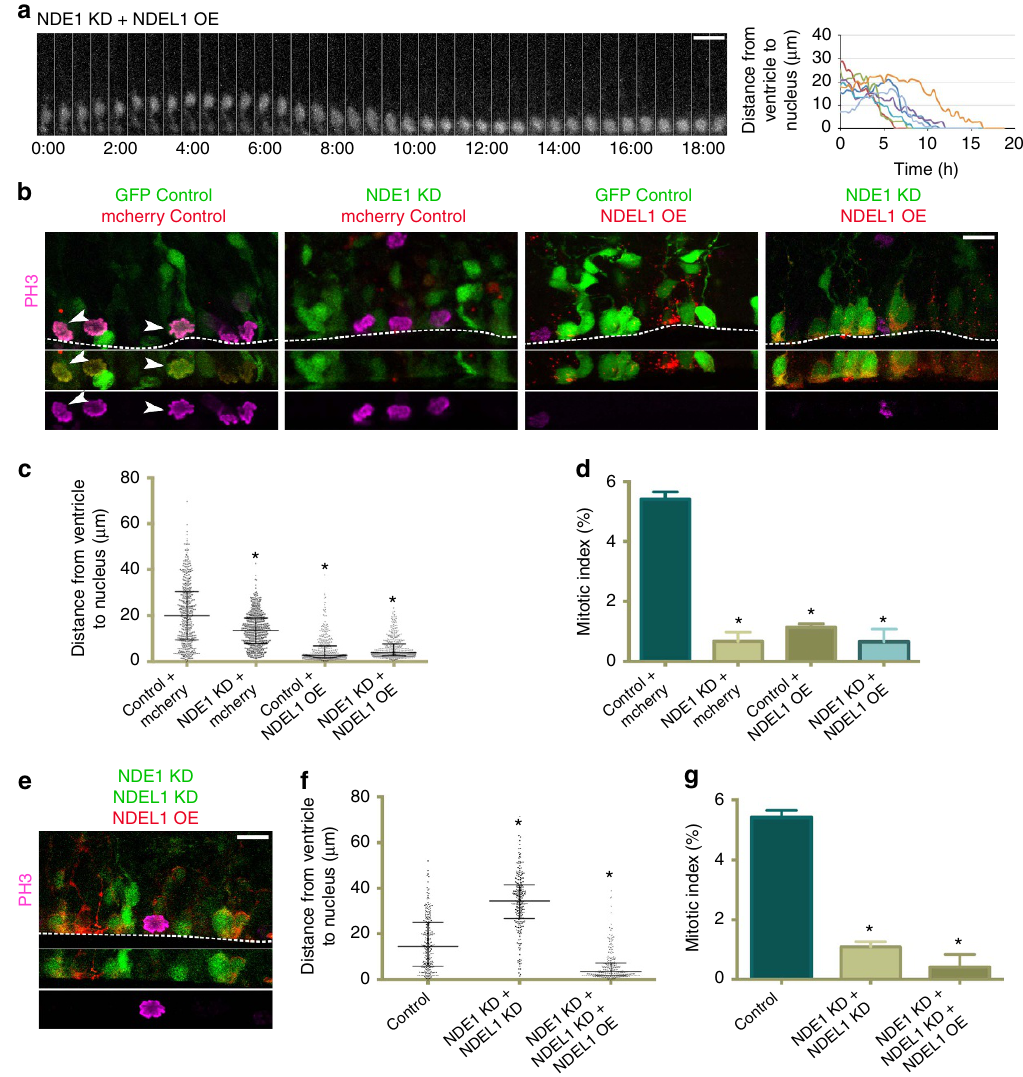
Figure 7 | NDEL1 overexpression rescues apical nuclear migration but not mitotic entry in NDE1 deficient radial glia progenitors. cDNA for NDEL1 was co-electroporated into embryonic rat brains with a GFP control empty vector or along with NDE1 shRNA or NDE1 and NDEL1 shRNAs at E16, and analysed at E20. ( a ) NDEL1 overexpression rescues apical interkinetic nuclear migration (INM) in radial glia progenitors (RGPs) where NDE1 has been knocked down, but these cells accumulate at the ventricular surface after apical INM, where they remain for hours without any evidence of mitosis. Montage panels are shown at 30min intervals. Full movie can be found in Supplementary Movie 7). ( b ) Representative images of NDEL1 overexpression on both a wild-type and NDE1 RNAi background reveals an accumulation of the majority of RGP nuclei at the ventricular surface in a PH3 negative state. Arrowheads mark electroporated cells in mitosis. Dashed line represents the ventricular surface. ( c ) NDEL1 overexpression causes nearly all RGP soma to accumulate at the ventricular surface regardless of whether NDEL1 is overexpressed on a wild-type or NDE1 RNAi background. ( d ) Even though NDEL1 overexpression caused an accumulation of RGP soma at the ventricular surface, the mitotic index remained reduced to a level similar to NDE1 knockdown alone. ( e ) Representative image of RNAi-resistant NDEL1 overexpression with NDE1/NDEL1 double knockdown in RGP cells stained for PH3. Dashed line represents the ventricular surface. ( f , g ) RNAi-resistant NDEL1 overexpression with NDE1/NDEL1 double knockdown caused an accumulation of RGP soma at the ventricular surface similar to overexpression of NDEL1 on a wild-type or NDE1-deficient background, and once again failed to rescue the mitotic index. Data are presented as scatterplot in c and f with bars representing the median ± the interquartile range, and as mean ± s.e.m. in d and g . Kolmogorov–Smirnov test for non- parametric distributions used in c and f (* P o 0.05, n ¼ 405-475 RGP cells in c and n ¼ 245–272 RGP cells in f ). Unpaired t -test used in d and g (* P o 0.05, n ¼ 3 embryonic brains from different mothers). Scale bars, 10 m m. Also see Supplementary Fig.